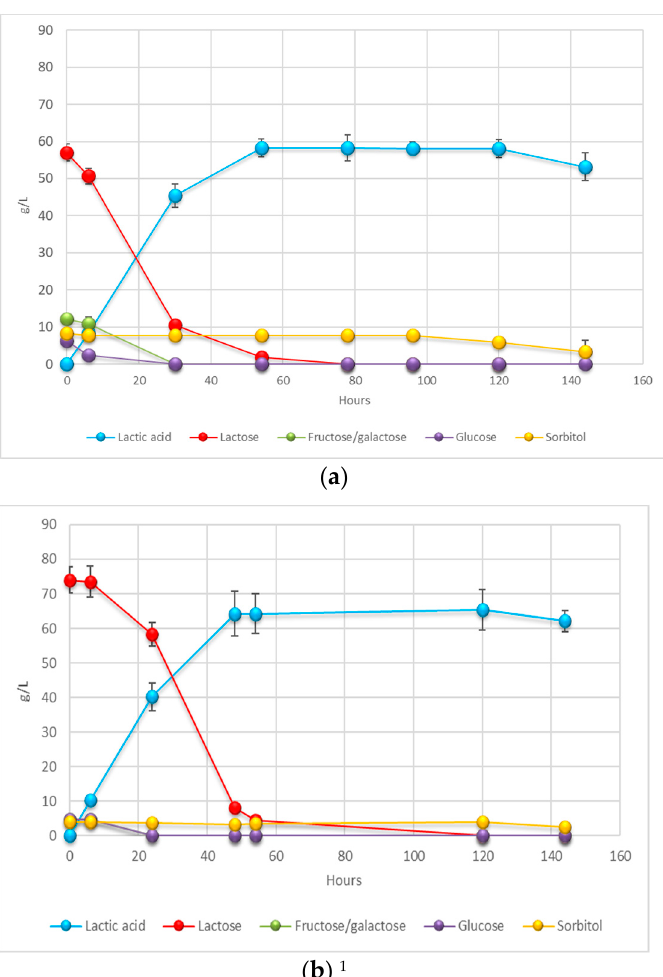
Figure 2. Trends in the concentration of sugars and LA in fermentations with RCW + PPR (70:30) ( a ) and RCW + centri- fuged PPR (90:10) ( b ), respectively. 1 the trend of fructose and galactose is covered by that of glucose.